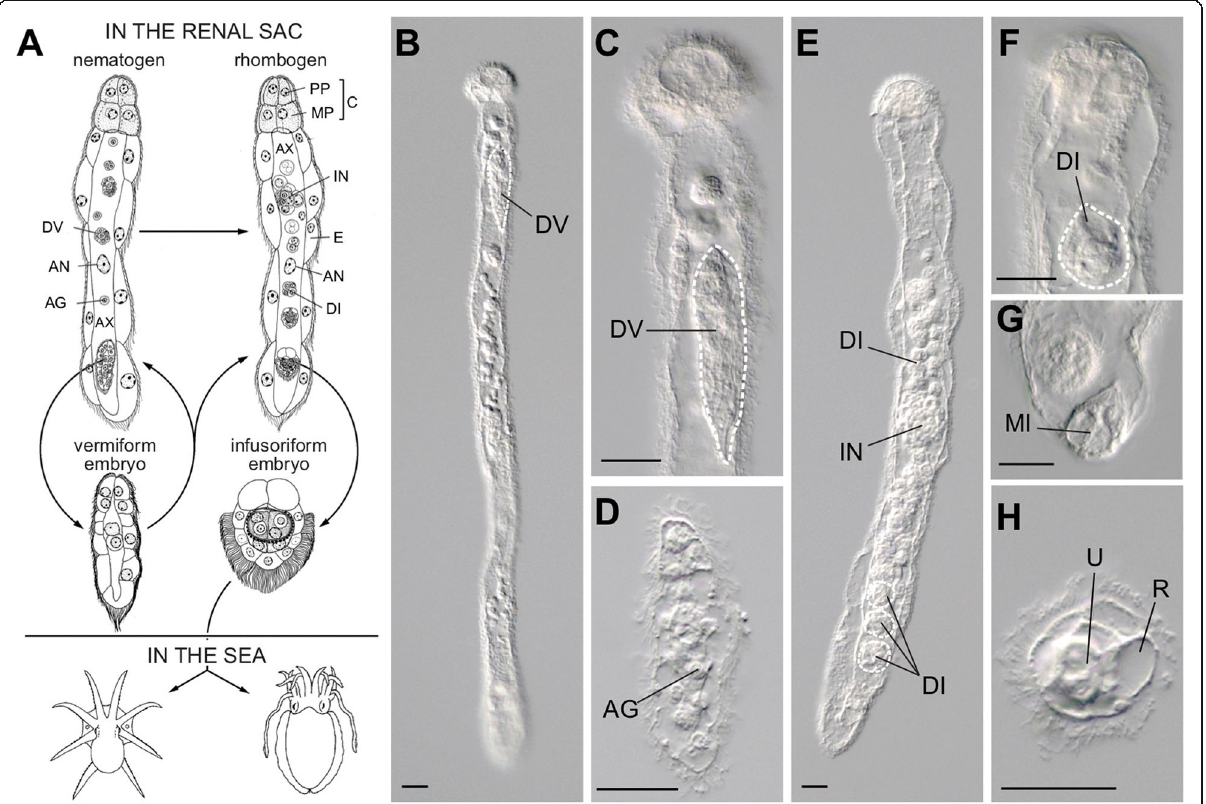
Fig. 1 The life cycle of dicyemid mesozoans. a Life cycle of dicyemids, see the text for details. Adapted and modified from Furuya and Tsuneki (2003). b-h Adult and larvae of Dicyema japonicum . b A nematogen, the asexual reproductive adult consisting of 22 somatic cells. c A vermiform embryo develops inside a nematogen. d A vermiform larva. e A rhombogen, the sexual reproductive adult. f An infusoriform embryo develops inside a rhombogen. g An infusoriform larva dispersing from a rhombogen. h A mature, free-living infusoriform larva escaped from the parent rhombogen. AG, agamete; AN, axial cell nucleus; AX, axial cell; C, calotte; DI, developing infusoriform embryo; DV, developing vermiform embryo; E, epidermal cell; IN, infusorigen; MI, mature infusoriform larva; MP, metapolar cell; PP, propolar cell. R, refringent body; U, urn cell. Scale bars: 20 μ m